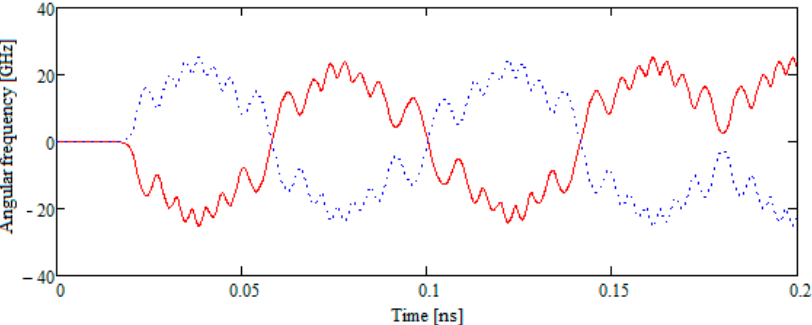
Figure 3. The angular speeds of the two B 42 discs.